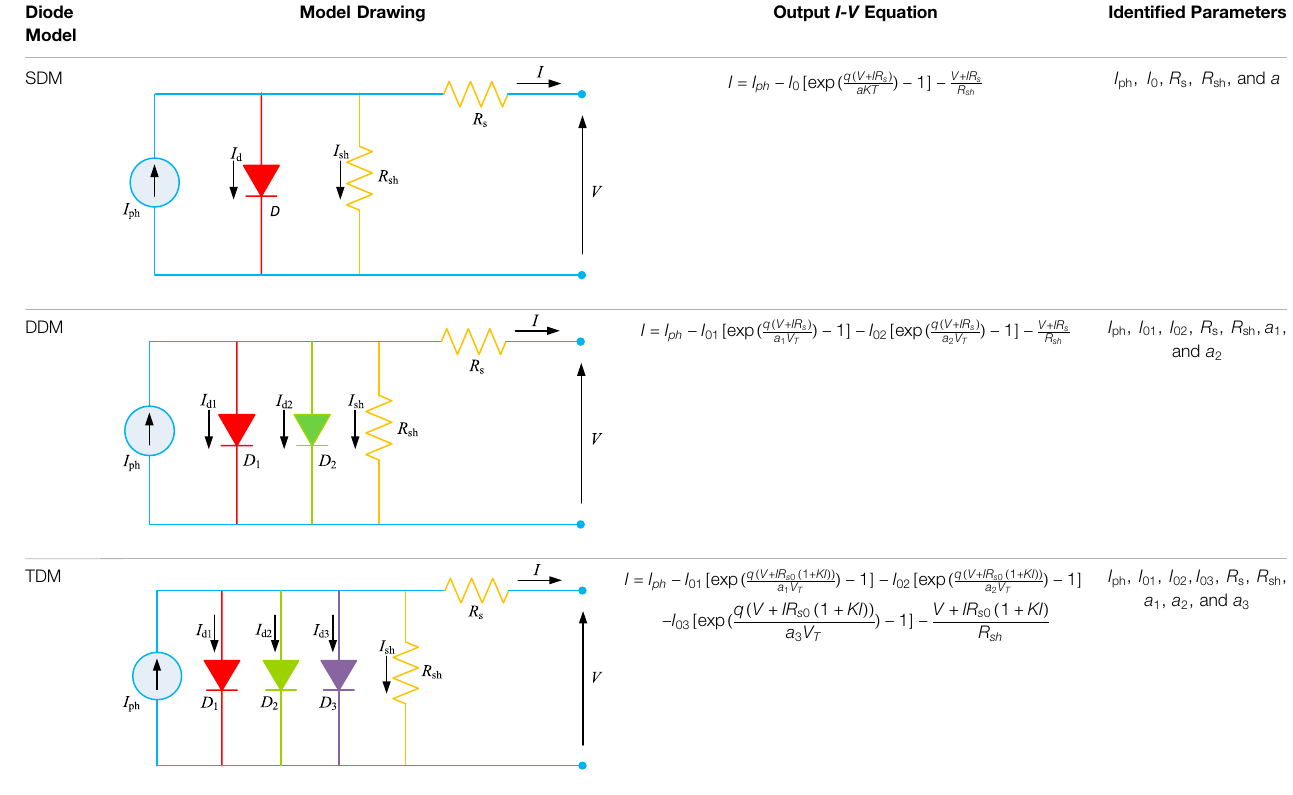
TABLE 1 | Three photovoltaic cell types. Diode Model